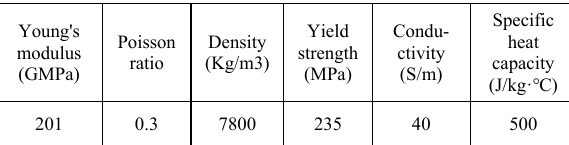
Table 1. Physical performance parameters of Q235 steel pipe